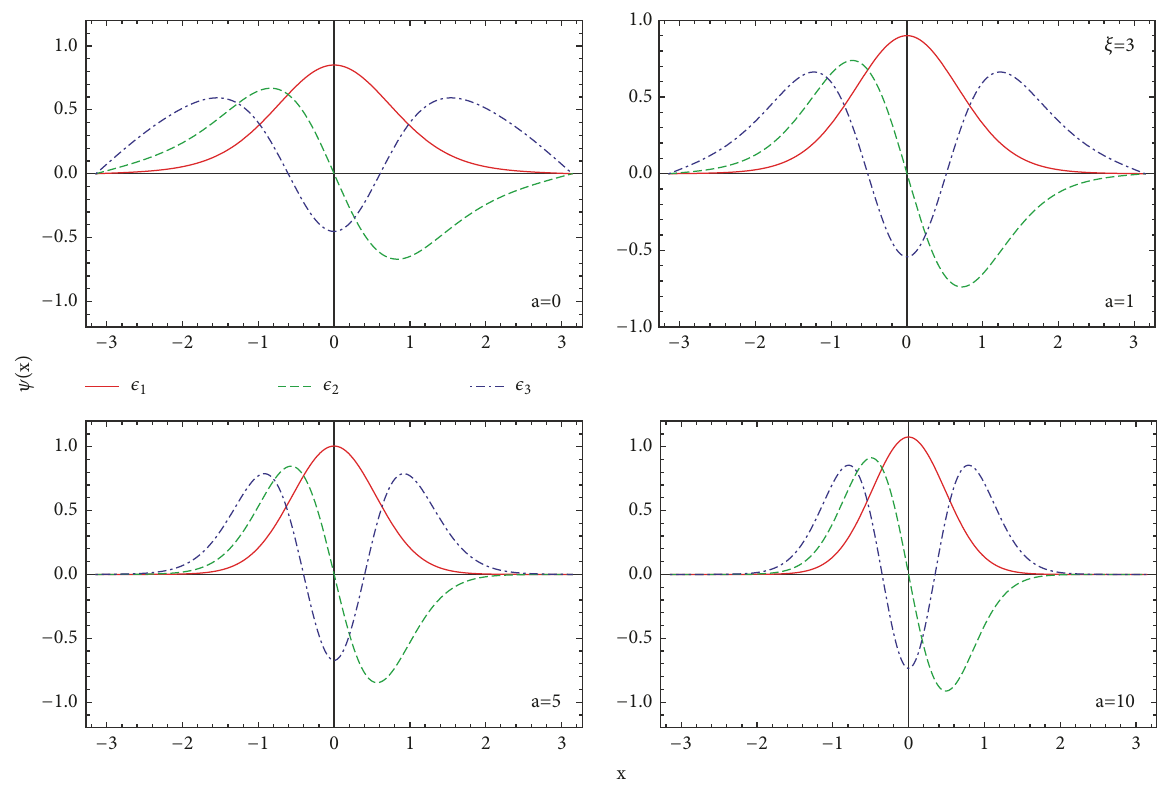
Figure 2: The characteristics of wave functions as a function of the position 𝑥 . We take 𝜉 = 3 .